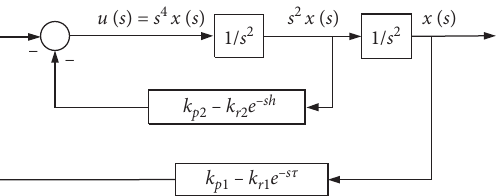
Figure 1: Schematic of the PR controller for a cascade